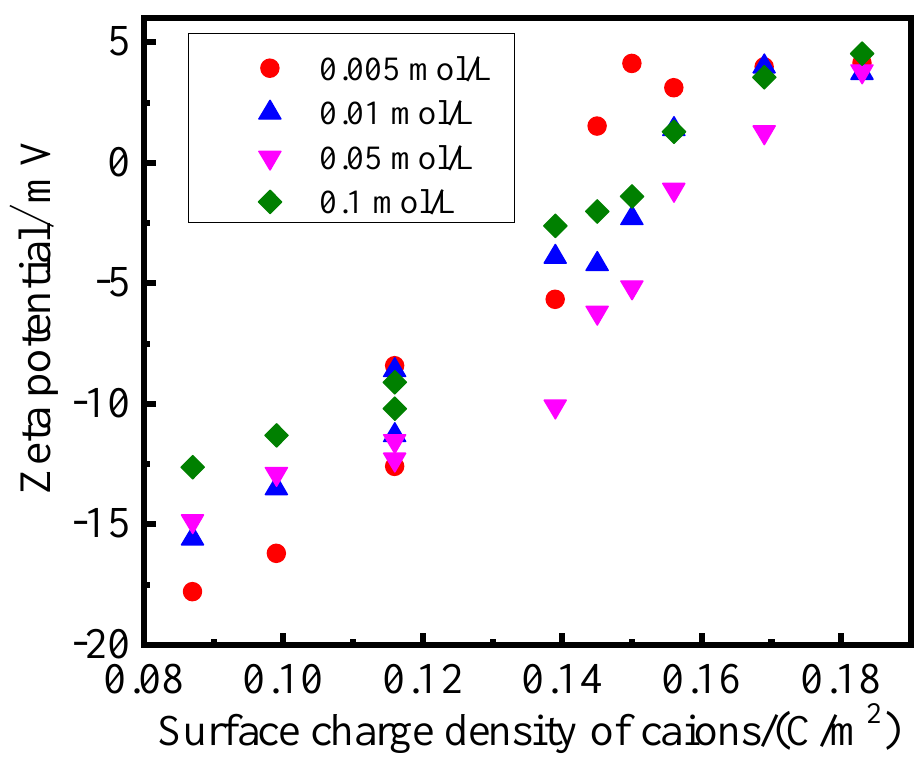
Figure 5. Relationship between surface charge density of cations and zeta potential.